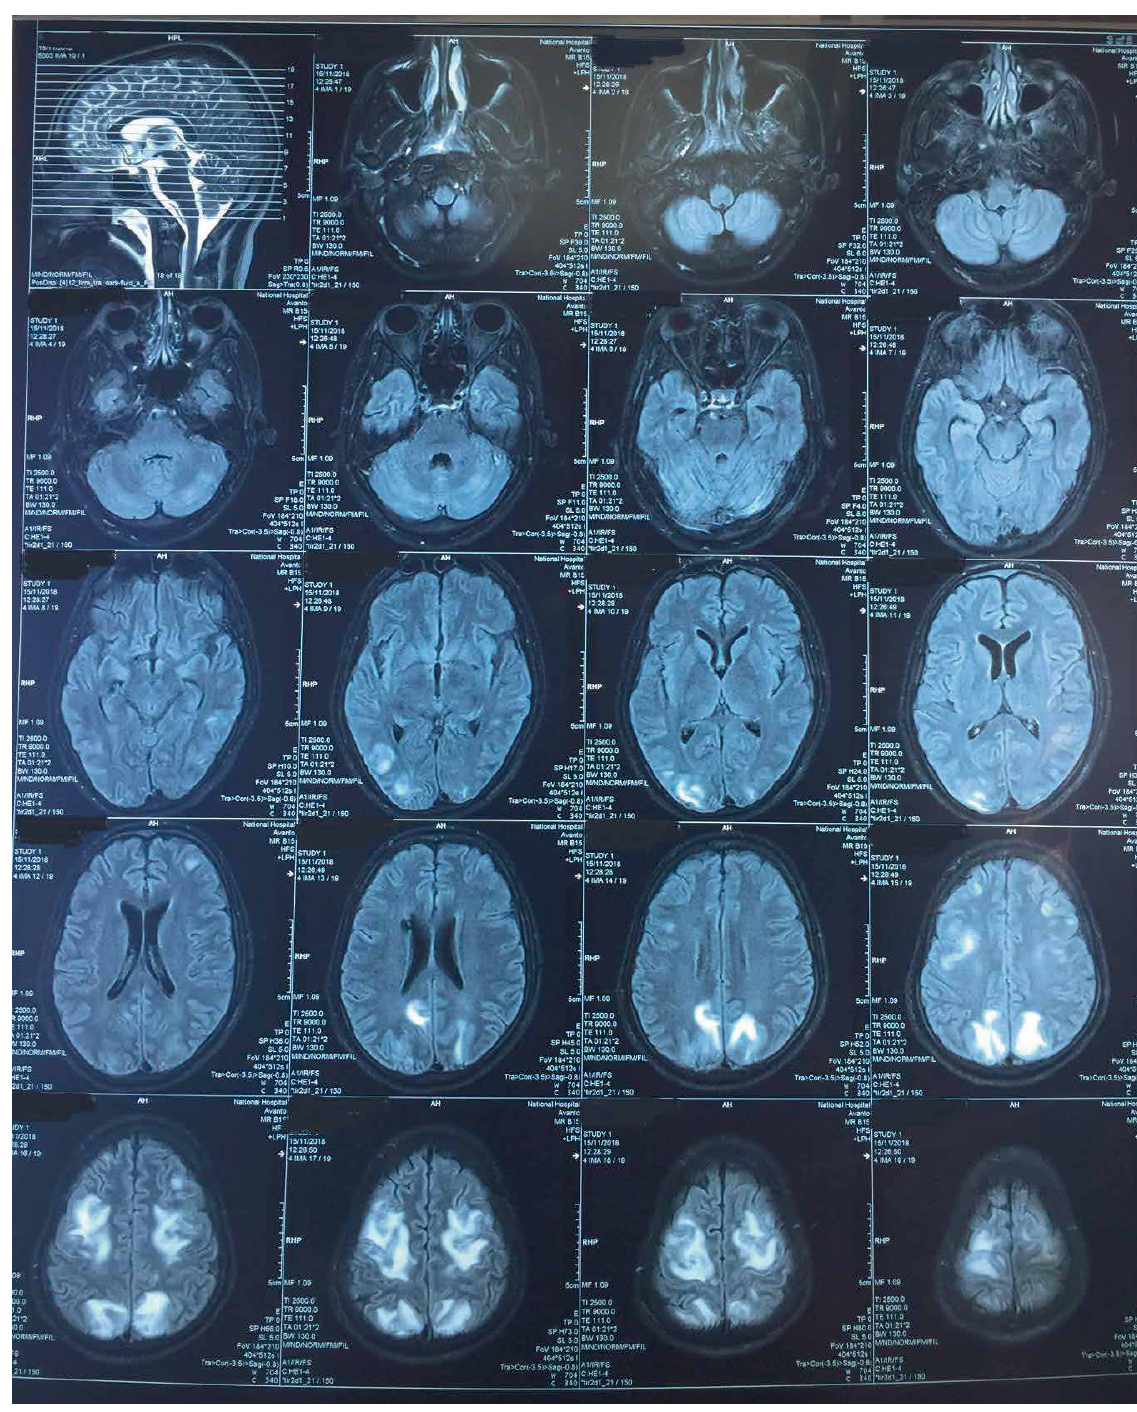
Figure 2: Magnetic resonant imaging showing bilaterally symmetrical parieto-occipital white matter